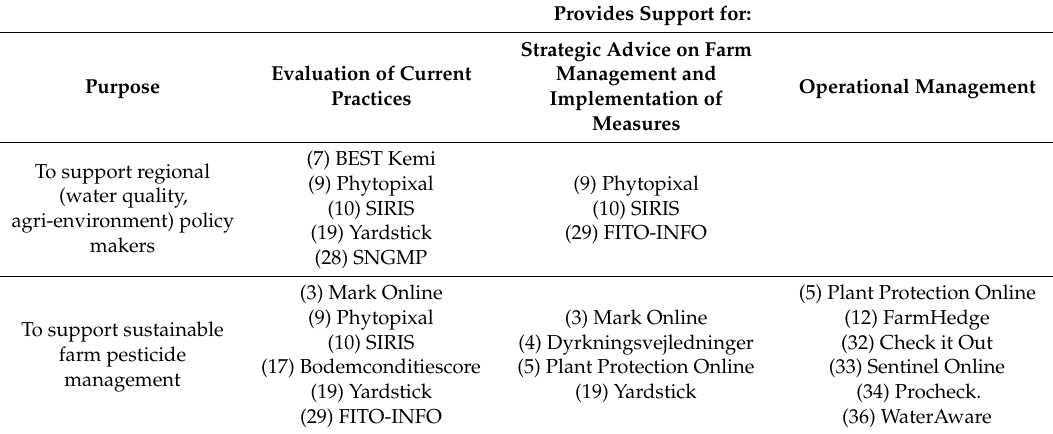
Table 2. Classification scheme for pesticide management DSTs (numbers in brackets refer to the DST number in Table